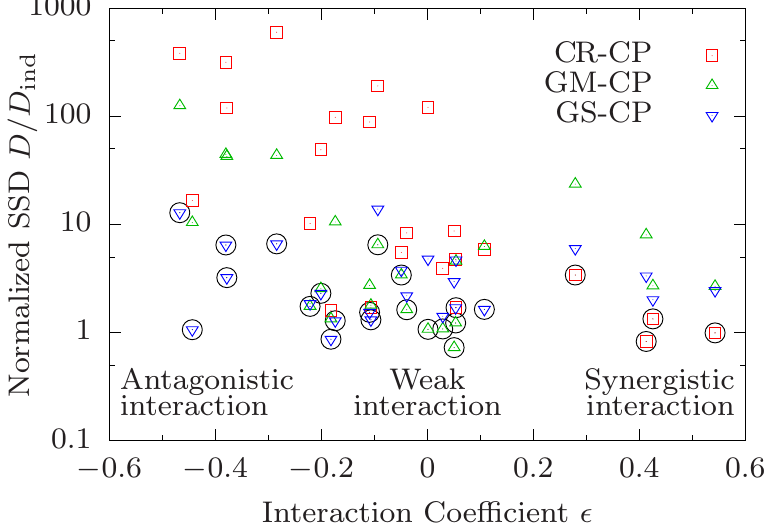
Figure 2. Preference for different composition principles correlates with interaction in median